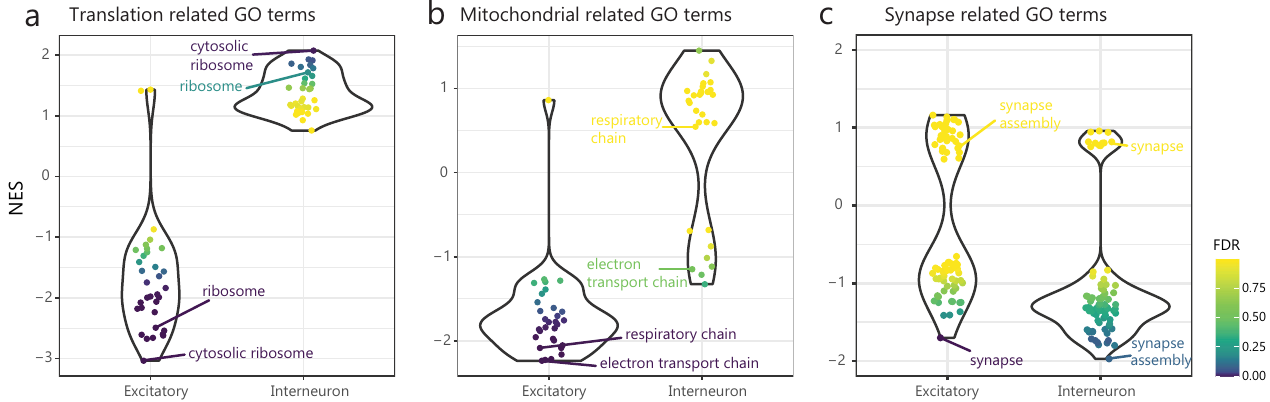
Fig 4. Neuron subtypes show diverse misregulated genes. Comparison of normalized enrichment scores (NES) across neuron subtypes for a) synaptic related GO terms (e.g. Synapse, GO:0045202; Synapse assembly, GO:0051963). b) translation related GO terms (c: e.g. Ribosome, GO:0005840; Cytosolic ribosome, GO:0022626) or c) mitochondrial function related GO terms (d: e.g. Respiratory chain, GO:0070469; Electron transport chain,